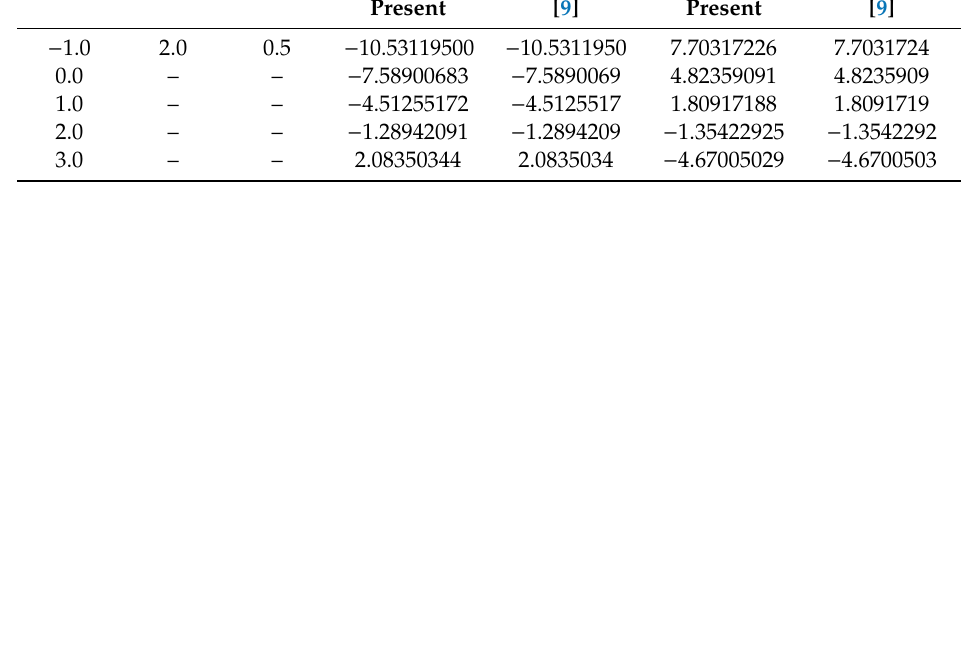
Table 2. Comparison with existing literature for 𝜙 = 0, 𝑀 = 0.5 .